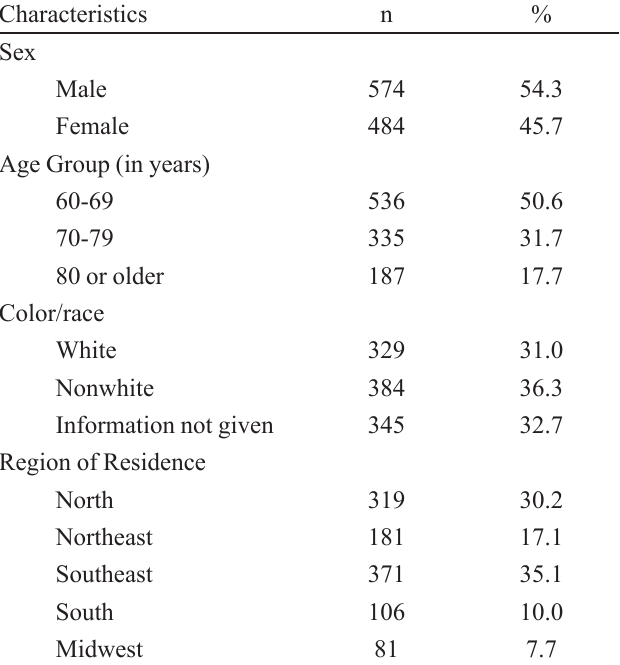
TABLE I - Demographic characteristics of elderly inpatients (n = 1,058). Brazil, 2008-2009